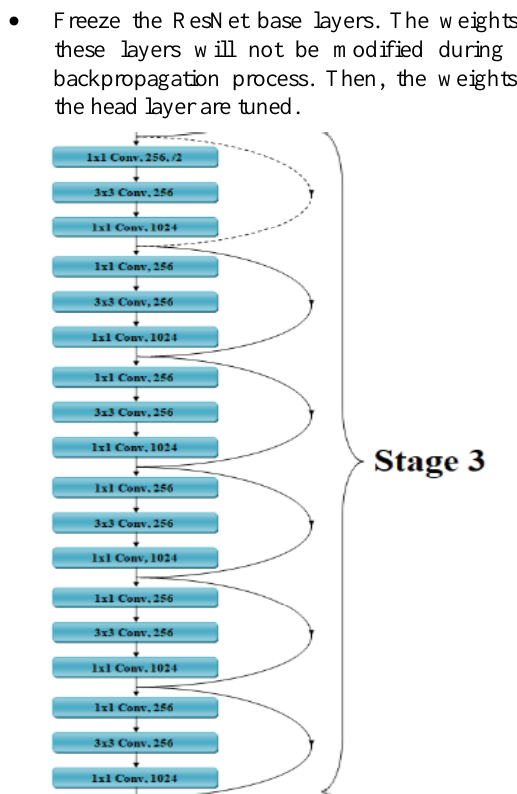
Figure 8. Stage 3 Architecture of ResNet50